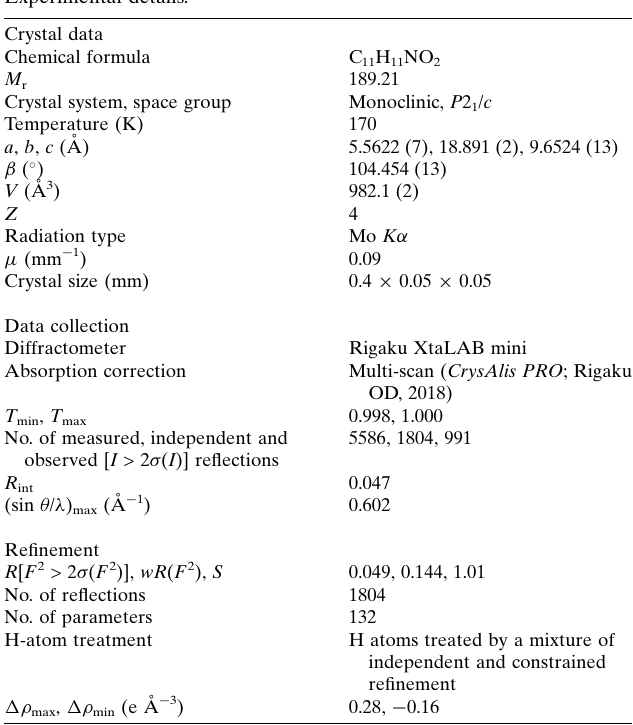
Table 2 Experimental details.